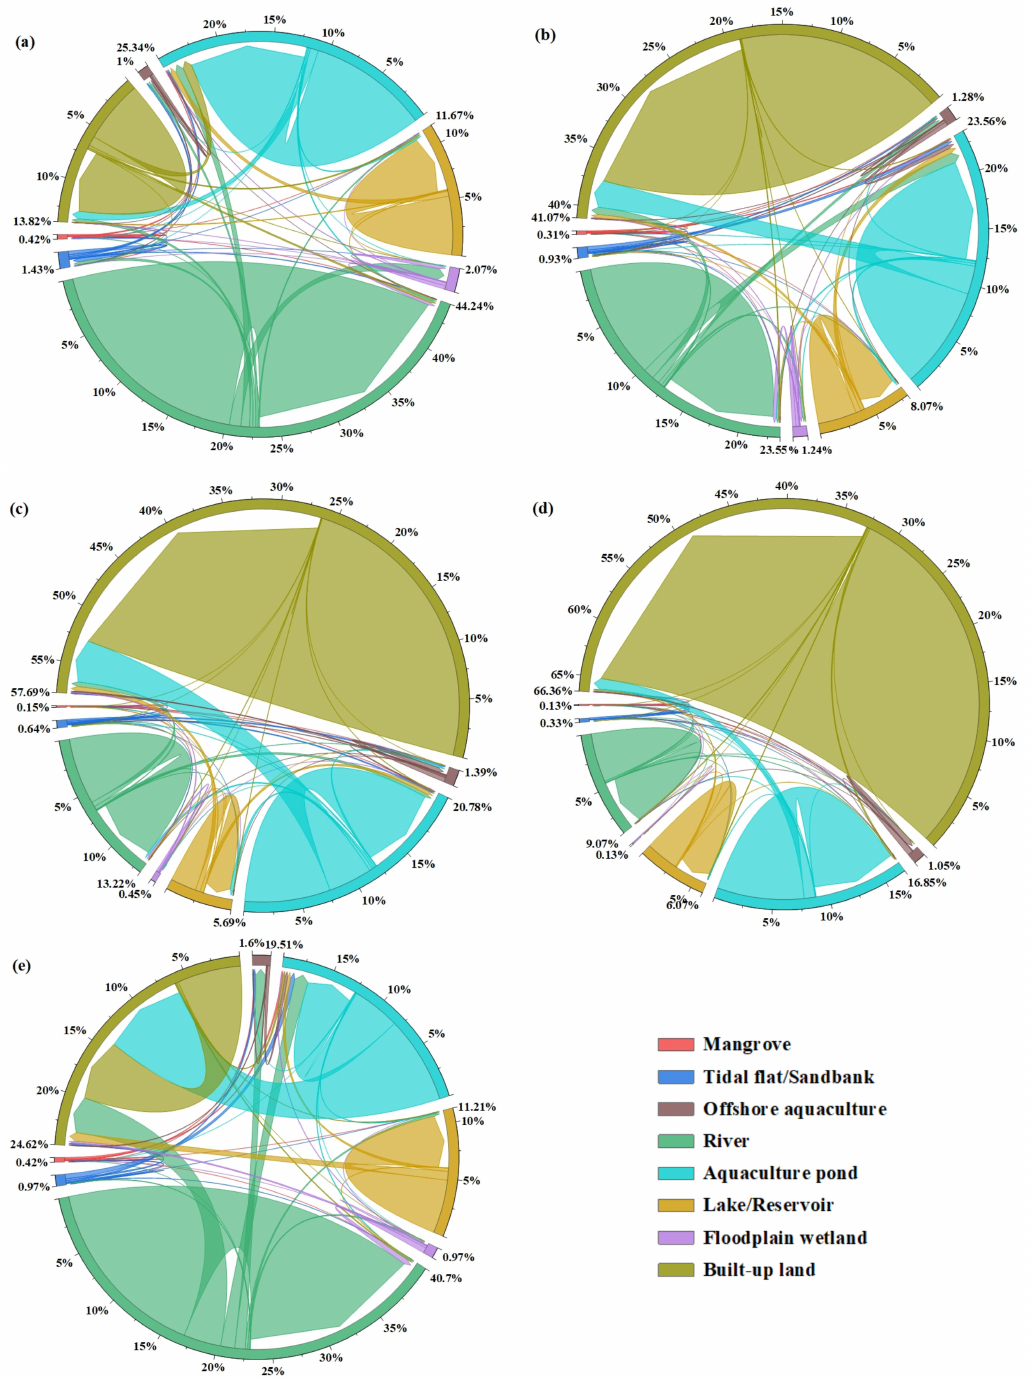
Figure 5. The chord diagrams of land use type transformation in the GBA ( a ) from 1976 to 1990, ( b ) from 1990 to 2000, ( c ) from 2000 to 2014, ( d ) from 2014 to 2019, ( e ) from 1976 to 2019. The arrows represent the direction of change, and the width of the arrows represents the extent of change. Each arc in the chord diagram represents the area transitioning from one land use type to